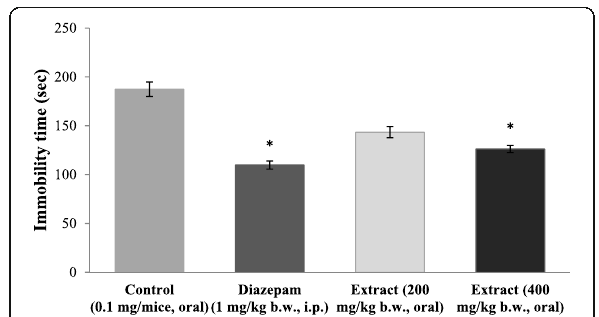
Table 4 Zone of inhibition of the ethyl acetate extract of D.